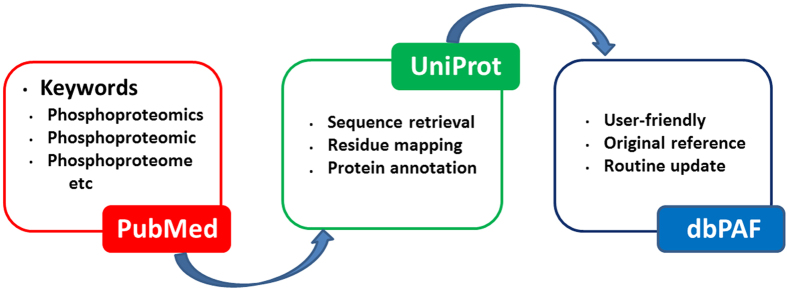
The procedure for the construction of dbPAF database.Also, we also integrated know phosphorylation sites from several public databases, including Phospho.ELM2223, dbPTM2427, PHOSIDA2526, PhosphositePlus2829, PhosphoPep3031, PhosphoGRID3233, SysPTM3435, HPRD36 and UniProt37.